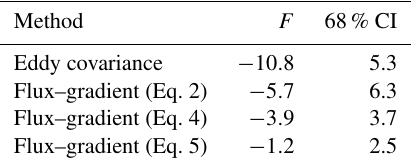
Table 1. Average PM 1 mass flux measured by eddy covariance compared to the average mass flux from two-point flux–gradient measurements using different K parameterizations. The confidence interval (CI) is given as the standard error of the mean (all units are ngm − 2 s − 1